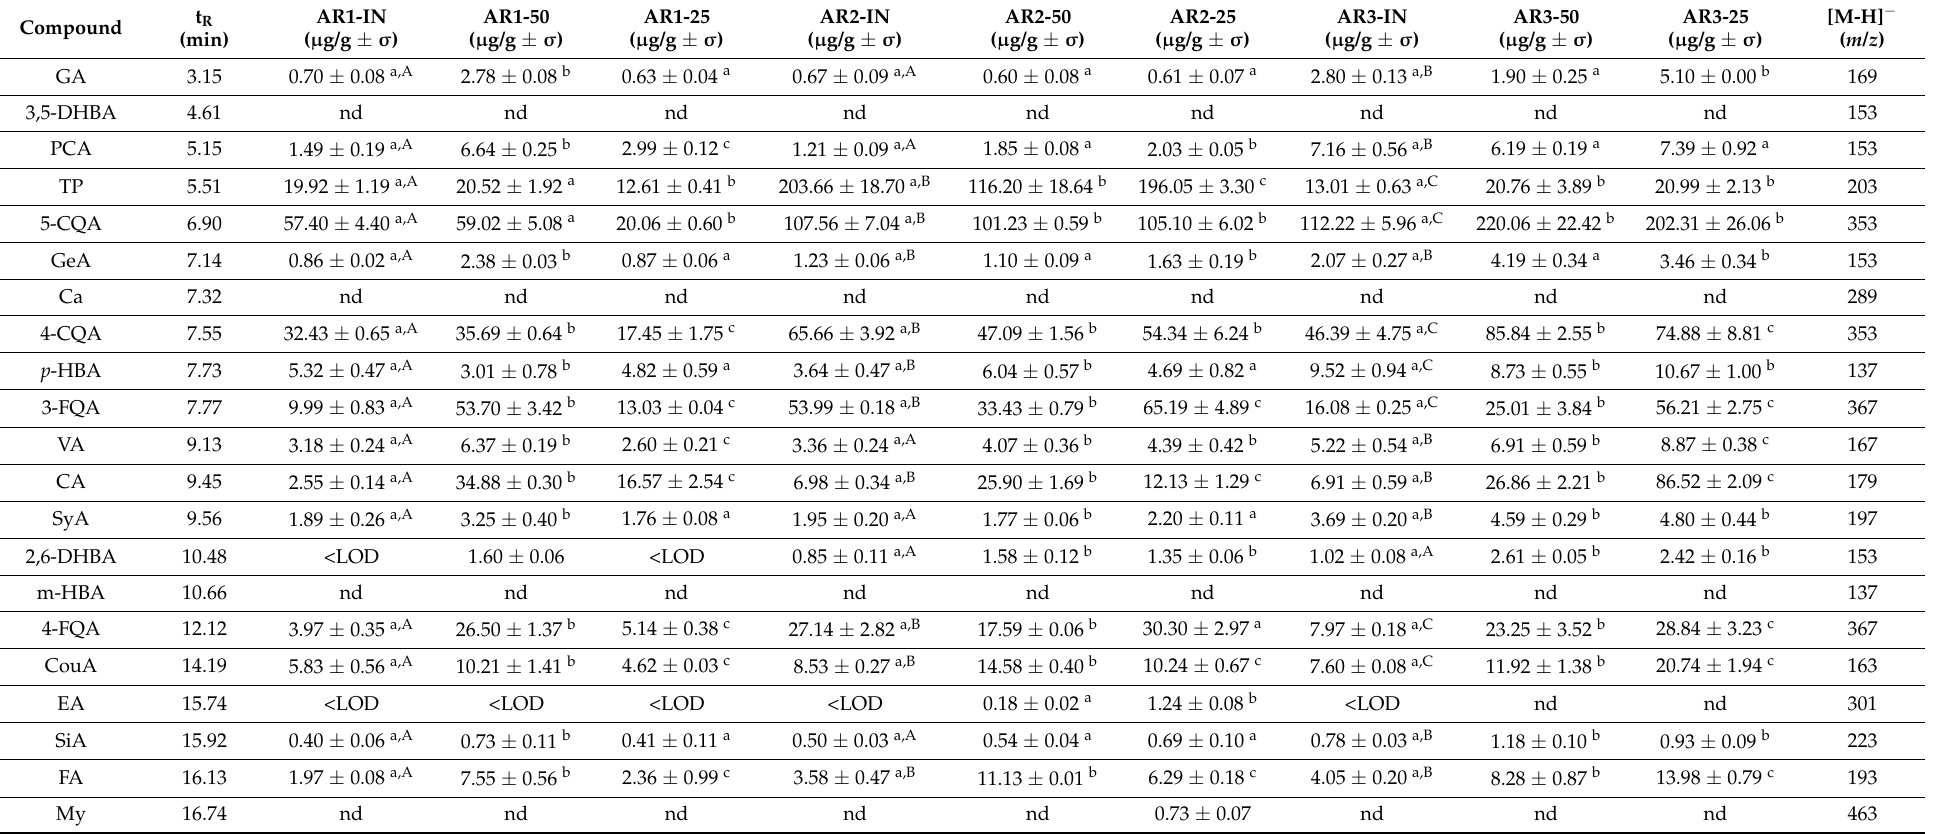
Table 5. Qualitative and quantitate data of phenolic compounds and tryptophan, identified by comparison with standard, in AR1, AR2, AR3 herbal tea (IN), aqueous extracts at 50 ◦ C (50) and 25 ◦ C (25), reported as µ g/g of dry rizhome, mean value of analysis in triplicate ± standard deviation ( σ ). t R : retention time; [M-H] − : monoisotopic mass of the deprotonated ion used for the SIR channel; values with different letters within rows are significantly different ( p < 0.05): a, b, c refer to the same rhizome (AR1, AR2 or AR3) extracts at different temperatures; A, B, C, refer to the three herbal teas AR1, AR2 and AR3. nd: not detected; < LOD: under LOD, calculated from the corresponding calibration curve. AR1-IN, AR2-IN, AR3-IN: herbal tea; AR1-50, AR2-50, AR3-50: aqueous extracts at 50 ◦ C; AR1-25, AR2-25, AR3-25: aqueous extracts at 25 ◦ C. EA quantitated as quercetin equivalent; 3-FQA and 4-FQA tentatively assigned and quantitated as ferulic acid